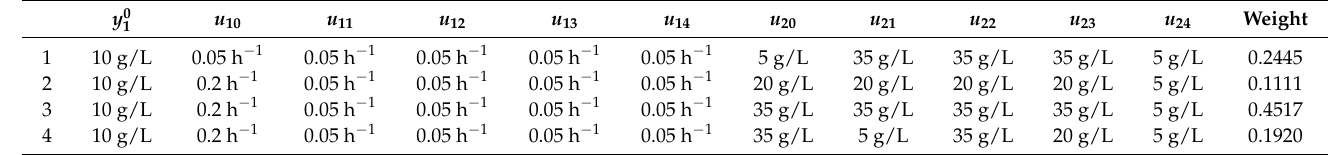
Table 11. Optimal design ξ VDM computed with the VDM for the yeast fermentation.